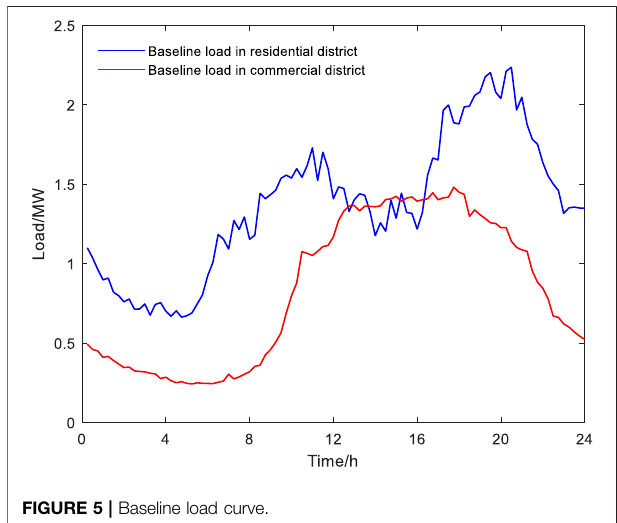
FIGURE 4 | Schematic diagram of distribution network functional districts.